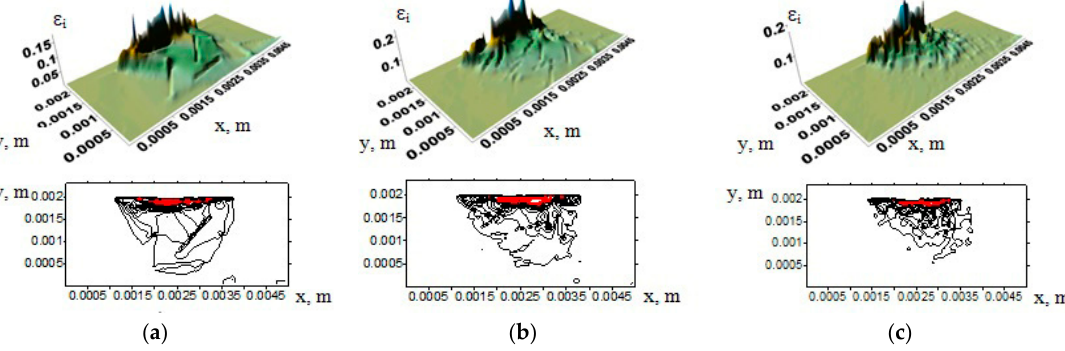
Figure 6. Strain distribution surfaces and their corresponding contours in samples filled with inclusions with a length of: ( a ) 1000 µm; ( b ) 500 µm; ( c ) 200 µm.